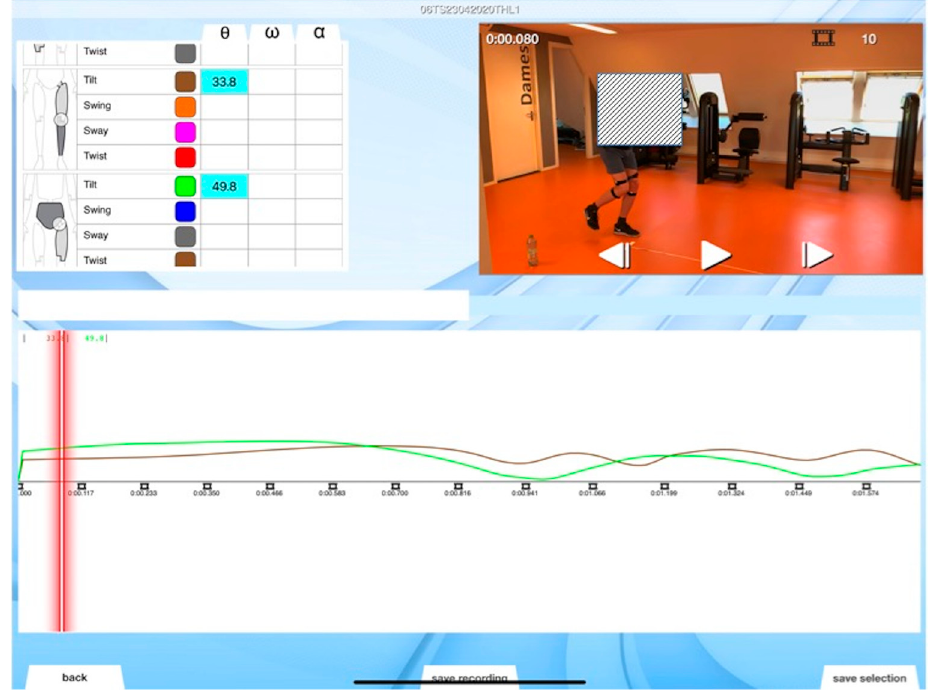
Figure 2. Screenshot of the SportsLapp app, with on-screen representation of video and kinematic data. Here left hip and knee data are visible.